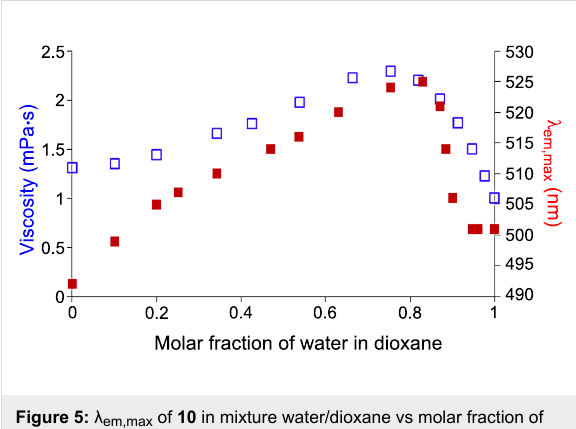
Figure 5: λ em,max of 10 in mixture water/dioxane vs molar fraction of water in dioxane (filled squares) and viscosity dependence [19] of a mixture water/dioxane vs molar fraction of water in dioxane (empty